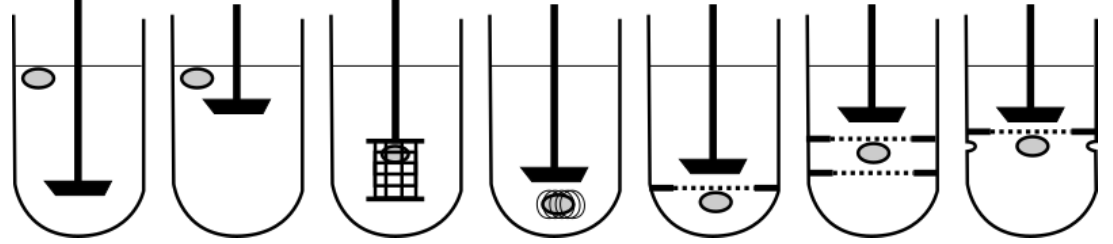
Figure 6. Compendial dissolution apparatus and modifications. Adapted from References [55].